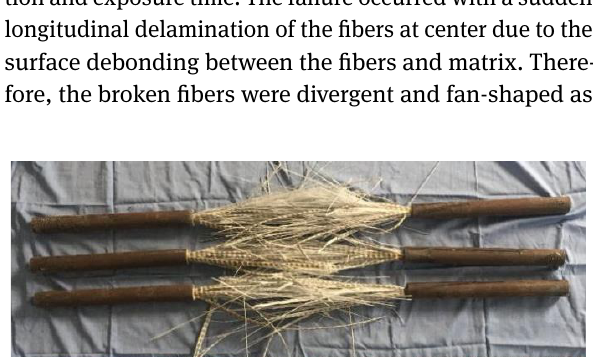
Figure 6: Tensile stress-strain curves of GFRP1 bars immersed in different